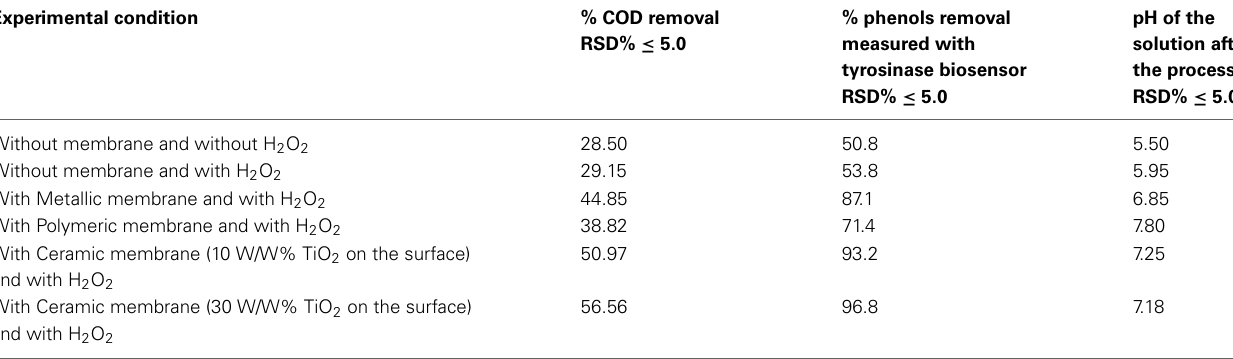
Table 3 | Percentage removal of COD and phenols with a (450 W) high pressure UV lamp after 24h. Experimental